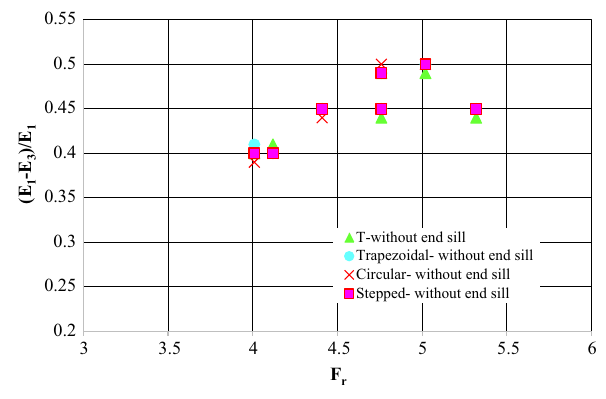
Fig. 15 Comparison of energy-dissipating ratios of the two rows without end sill energy dissipaters